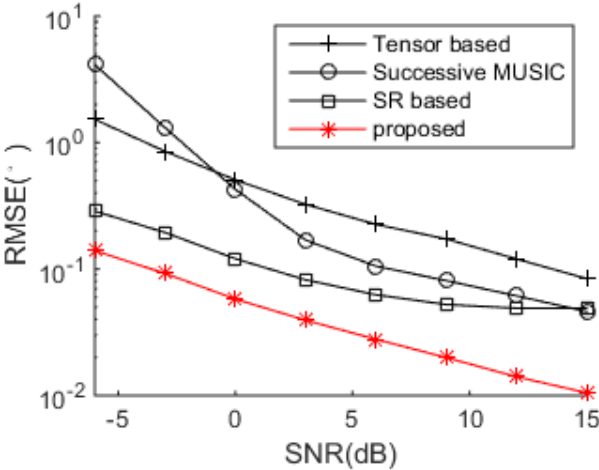
Figure 4. DOA estimation performance comparison.